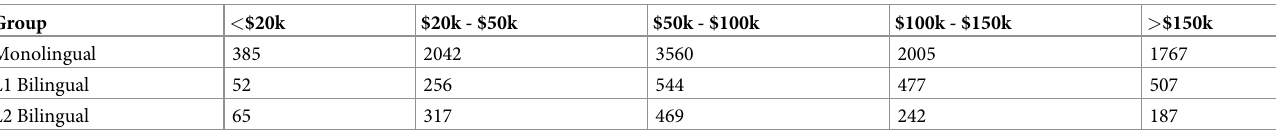
Table 2. Sample sizes for the income levels and language